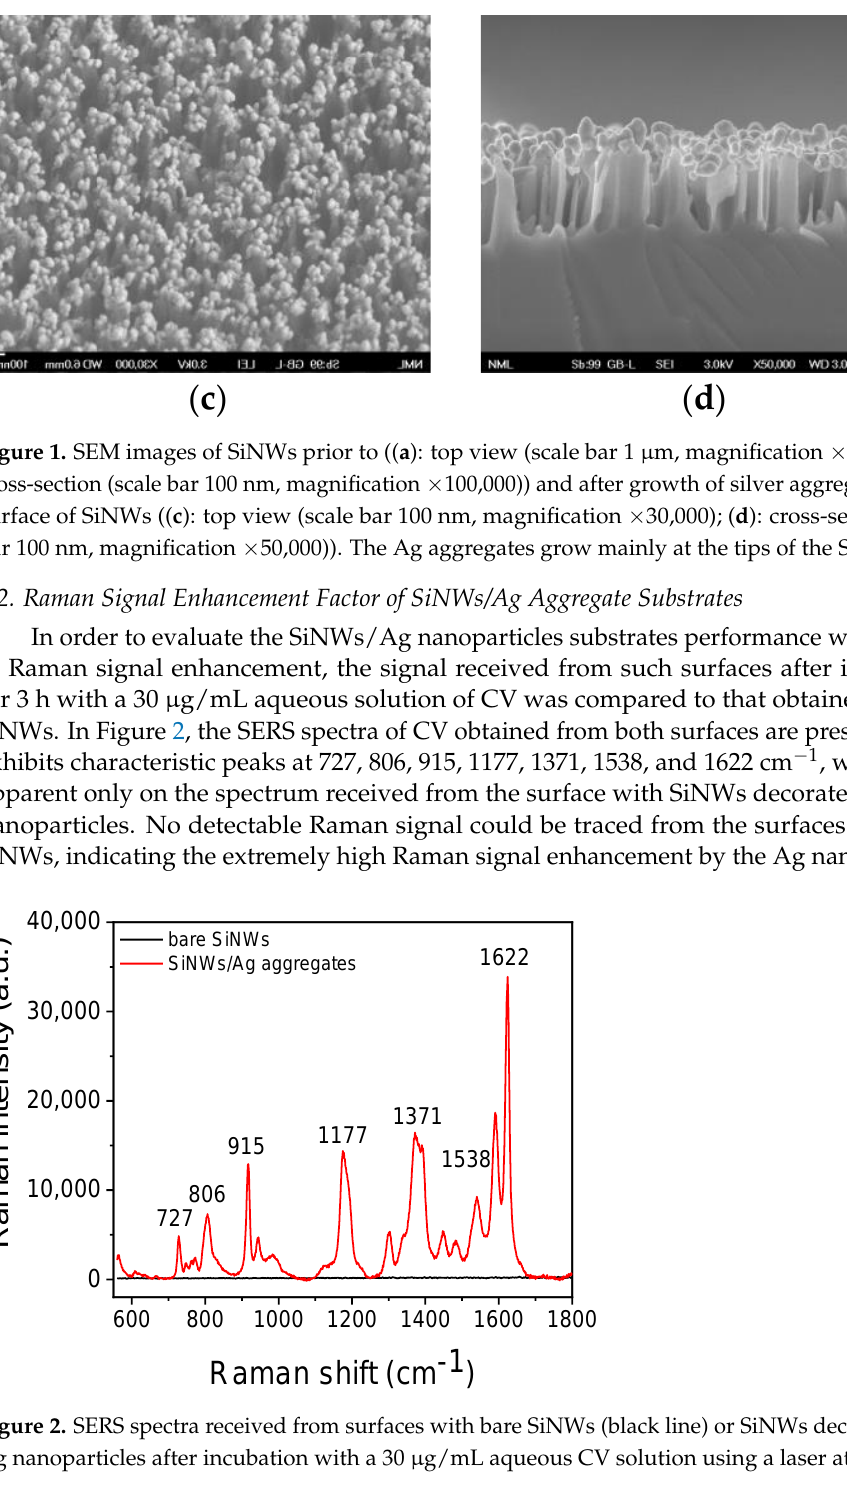
Figure 2. SERS spectra received from surfaces with bare SiNWs (black line) or SiNWs decorated with Ag nanoparticles after incubation with a 30 μ g/mL aqueous CV solution using a laser at 532 nm. 3.3. GSH Determination with SERS For the determination of GSH in the SiNWs/Ag nanoparticles substrates, two differ- ent approaches were investigated: the first is based on direct detection of GSH bound onto